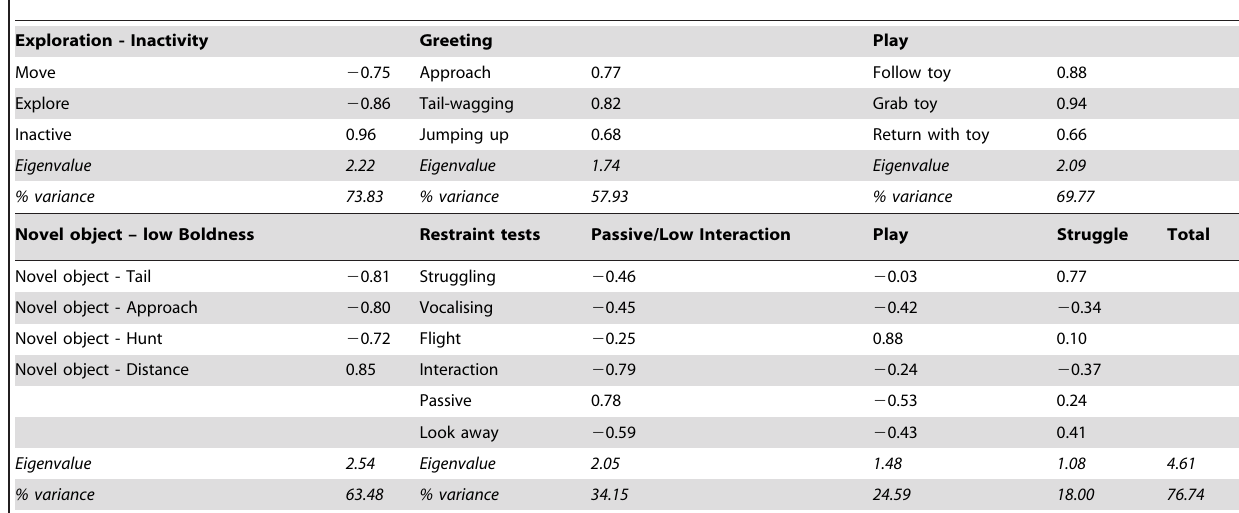
Table 8. Components and component loadings of CATPCA over selected variables from the puppy